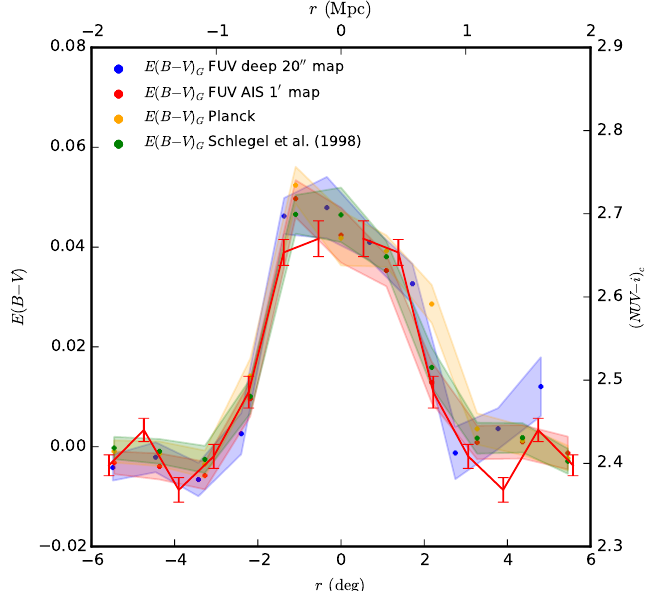
Figure 7. Radial E ( B − V ) reddening profile (filled circles + uncertainties as shaded area), right y -axis show ( NUV − i ) color, 5 ◦ = 1.44 Mpc, from negative to positive is radial direction from the southern to northern parts of the Virgo cluster, the red line with error bars shows colors averaged over the north and south parts of the cluster; different colors of circles correspond to corrections for galactic contaminations, making use of different galactic FUV maps as described in [176–178], green, yellow, red 1 (cid:48) , and blue 20 (cid:48)(cid:48) , correspondingly. Credit: Longobardi et al. [33]. A&A, 633, L7, 2020, reproduced with permission ©